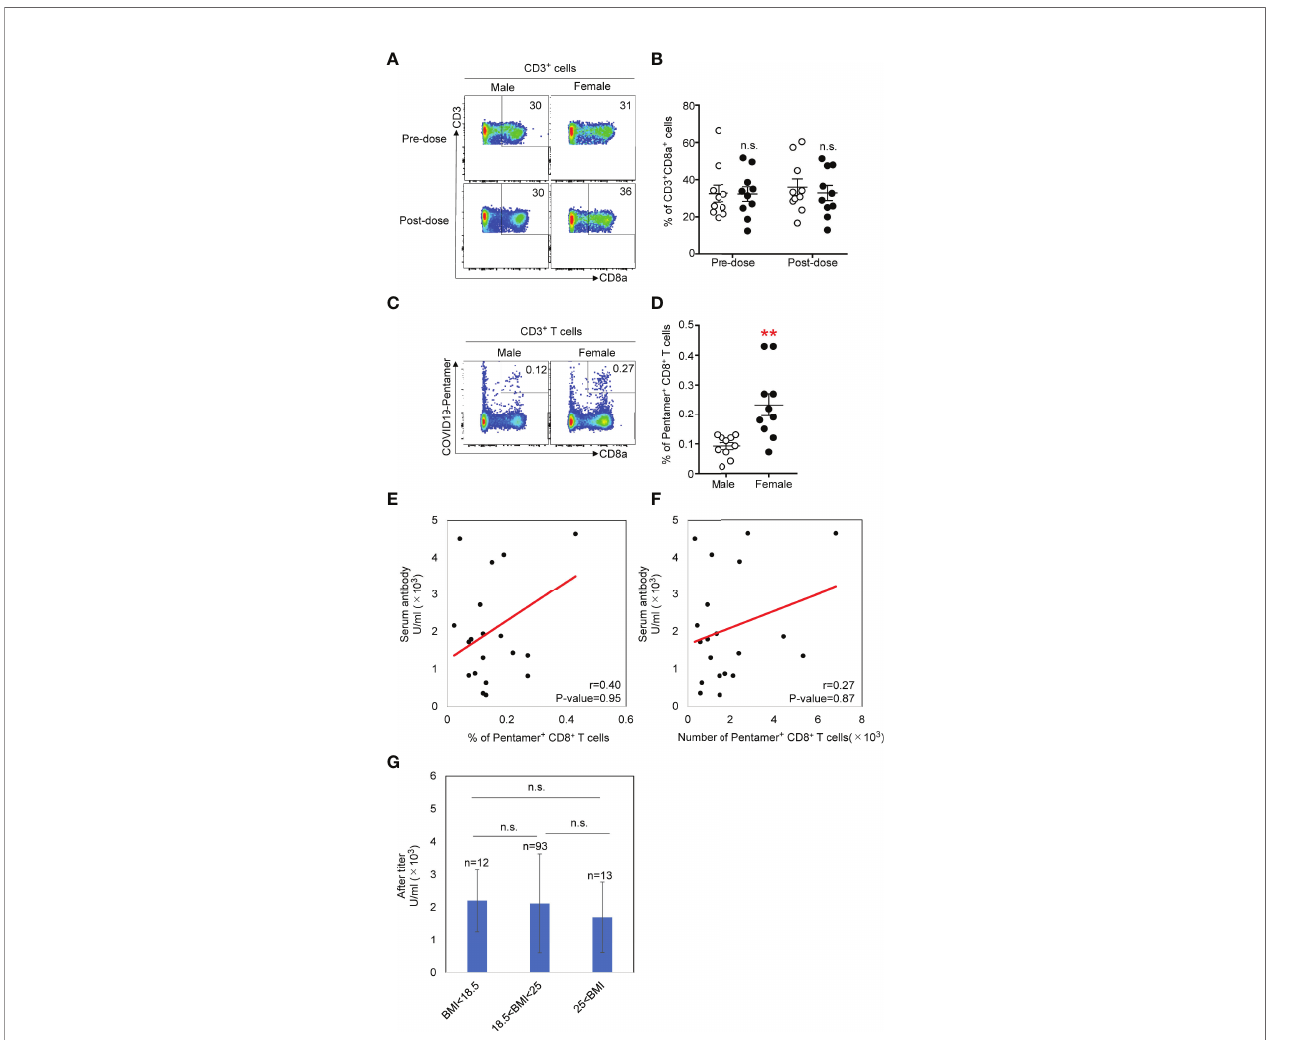
FIGURE 2 | (A) Flow cytometric analysis of total CD8 + T cells isolated from PMBCs from males or females. Dot plots of CD3 and CD8 expression in propidium iodide - (PI - ) CD3 + PMBCs from males or females are shown. (B) Number of CD3 + CD8 + T cells in PMBCs from males or females before and after vaccination. (C) Flow cytometric analysis of CD3 + CD8 + COVID-19-pentamer + T cells isolated from PMBCs from males or females after vaccination. Plots of CD8 and COVID-19-pentamer expression in PI - CD3 + PMBCs from males or females are shown. (D) Number of CD3 + CD8 + COVID-19-pentamer + T cells among PMBCs from males and females after vaccination **p < 0.01. (E) Scatter plots of antibody titer and COVID-19-pentamer + CD8 + T cell frequency in males and females after vaccination. (F) Scatter plots of antibody titer and cell number of COVID-19-pentamer + CD8 + T cells in males and females after vaccination. (G) Scatter plots of body mass index and cell number of COVID-19-pentamer + CD8 + T cells in males and females after vaccination. n.s., not signi fi